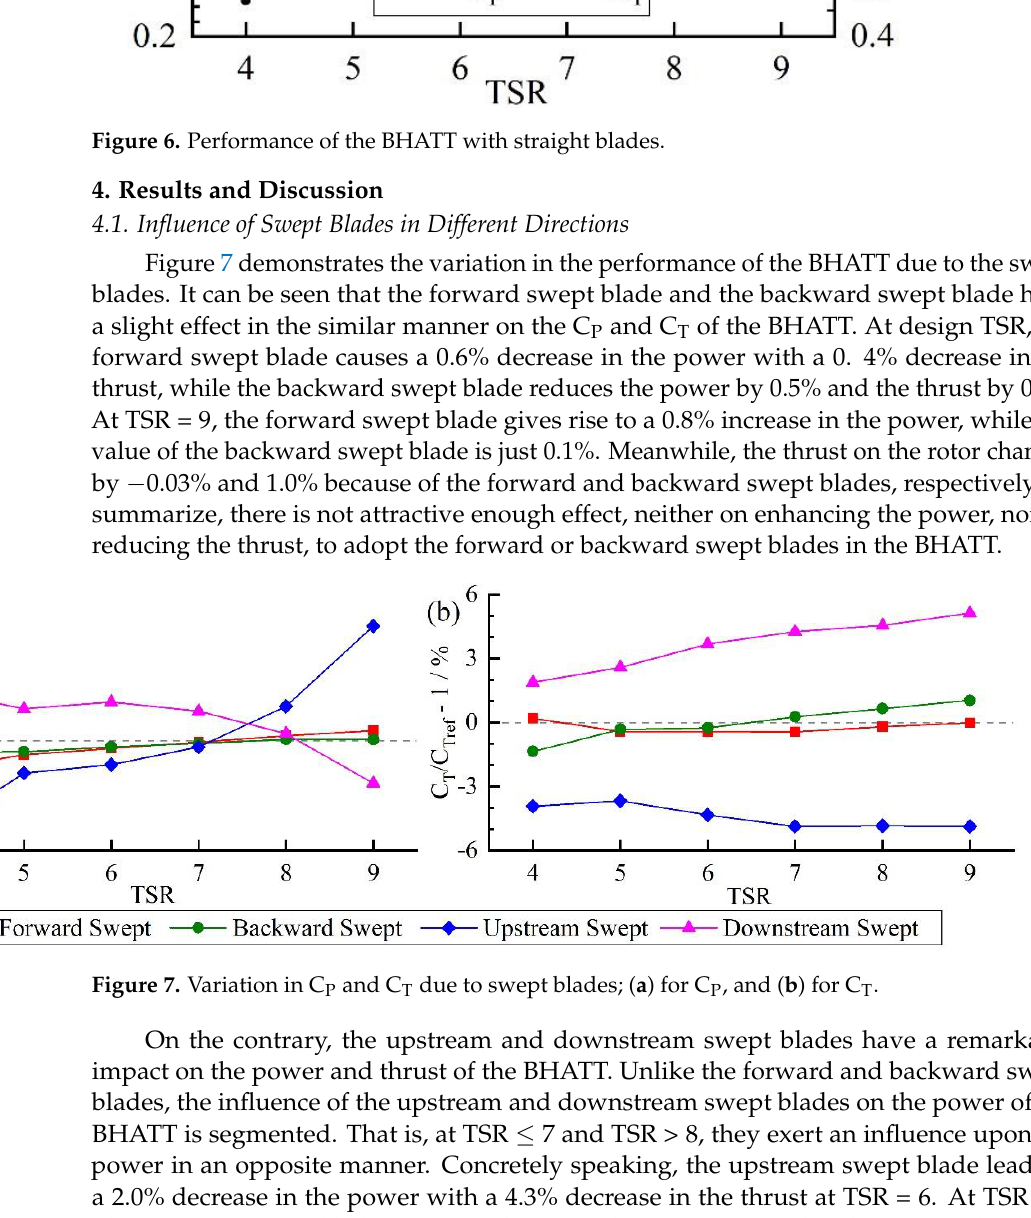
Figure 7. Variation in C P and C T due to swept blades; (a) for C P , and (b) for C T .